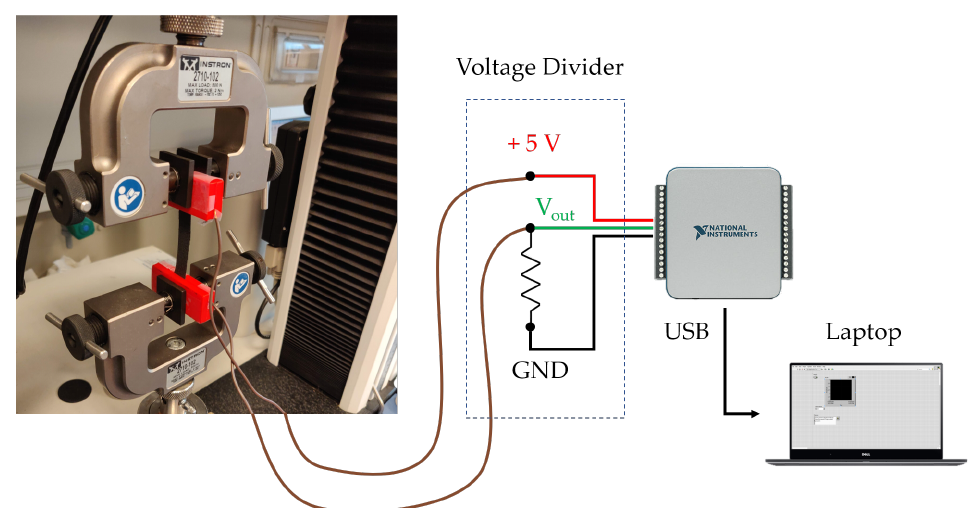
Figure 1. Experimental setup used for the characterization of the sensing elements